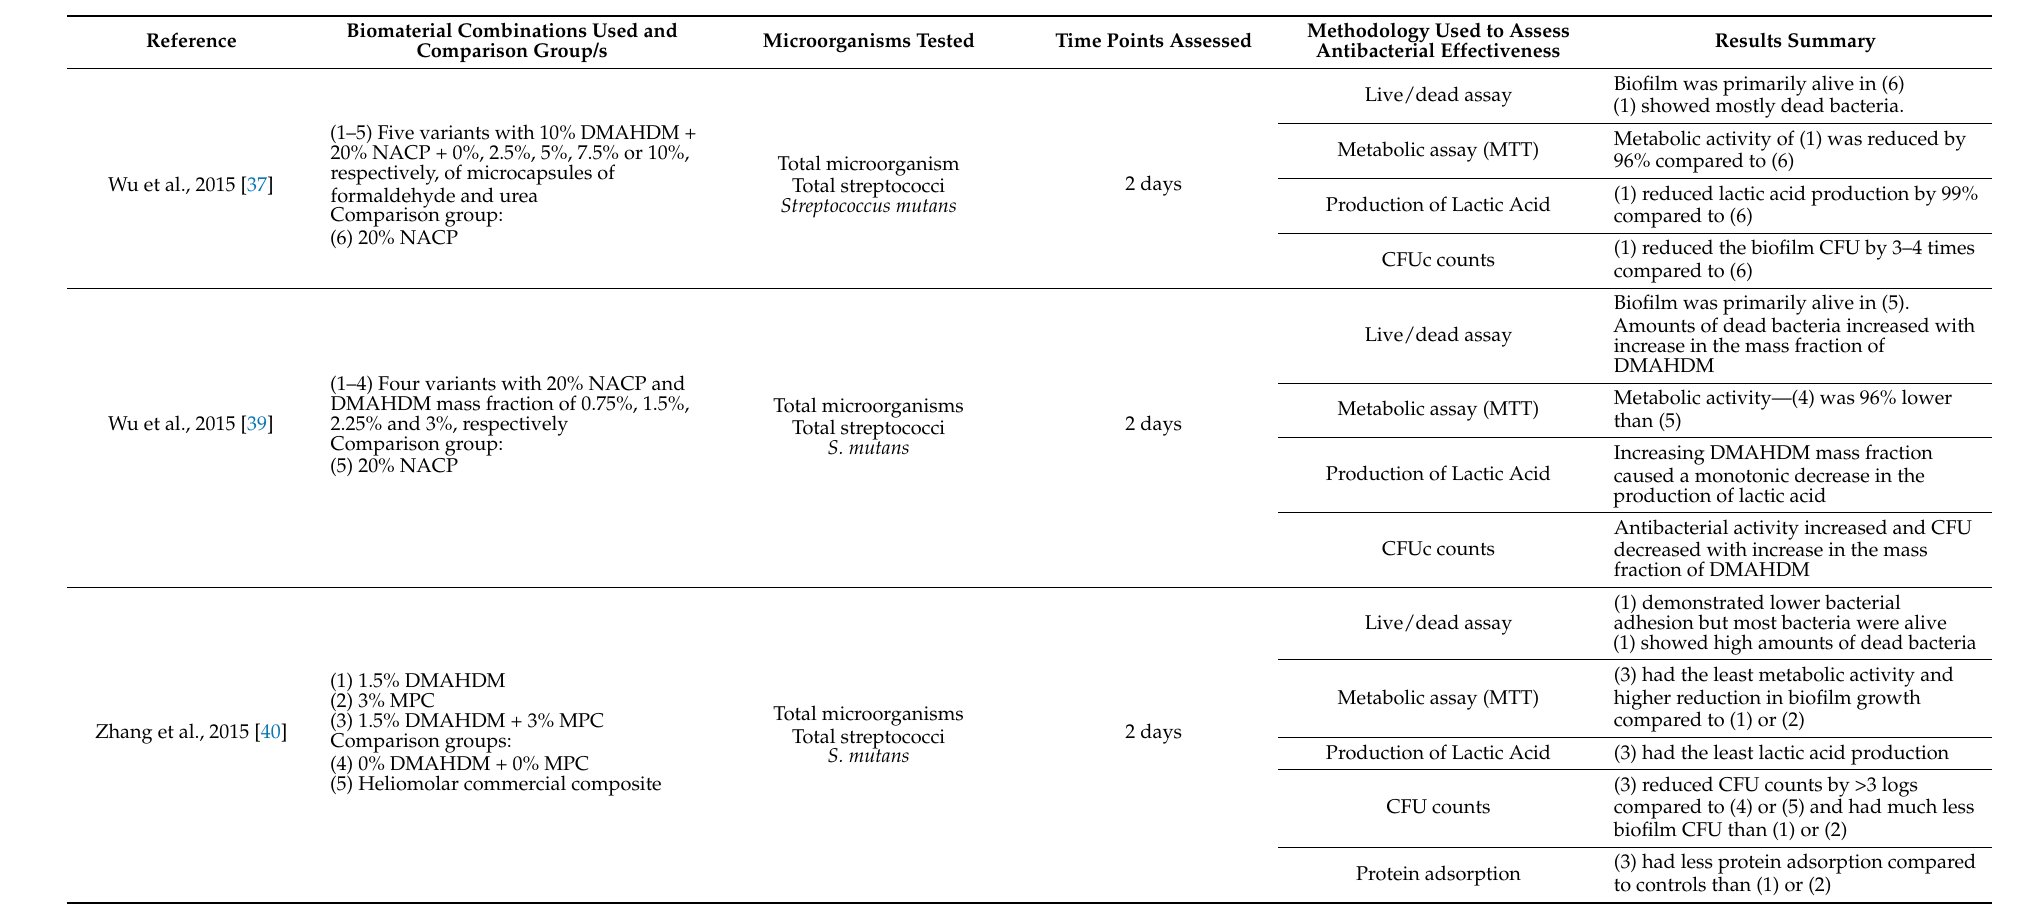
Table 4. Antibacterial